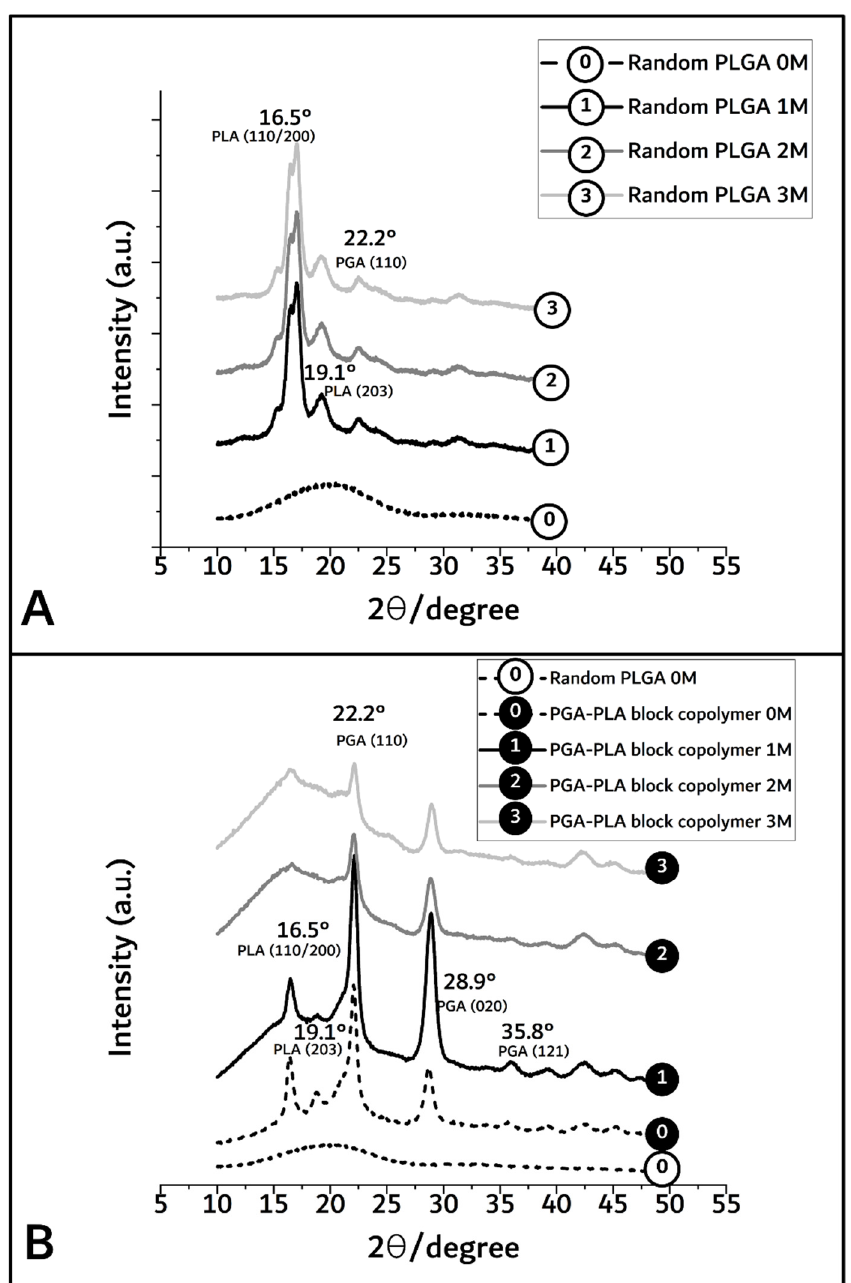
Figure 5. XRD spectra of random PLGA ( A ) and PGA–PLA block copolymer ( B ), harvested 0 to 3 months after